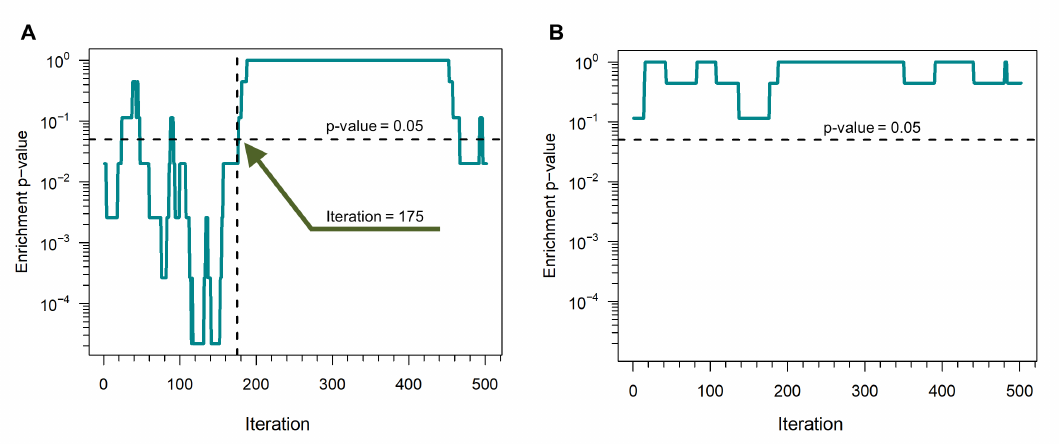
Figure 10. Performance of SWIM in human breast invasive carcinoma. ( A ) Enrichment p -values of switch genes in seed genes obtained by running SWIM for breast invasive carcinoma. ( B ) Enrichment p -values for a subset of genes drawn randomly from the network in seed